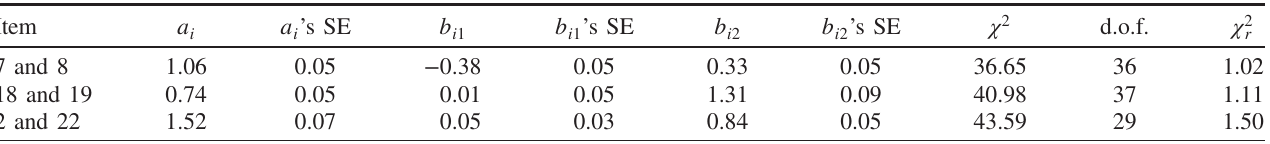
) and thresholds ( b and b ) of the three polytomous items from the reduced LSCI, along with their i i 1 i 2 ) values are also r